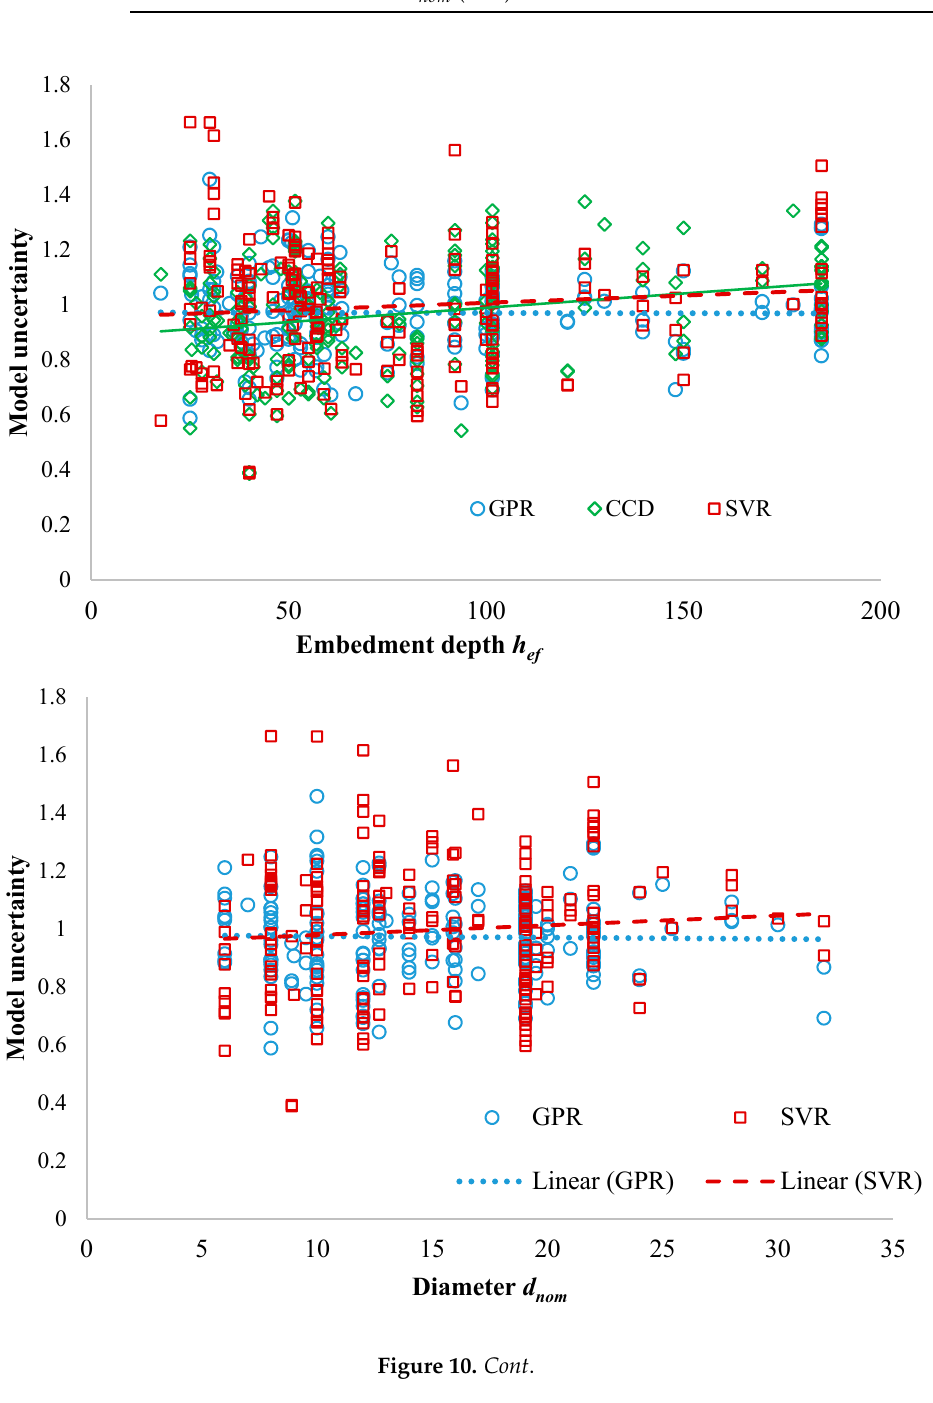
Figure 10. Scatter plots of Model uncertainty versus breakout parameters for all the models. Table 5. Trend analysis of the model uncertainty. Parameters